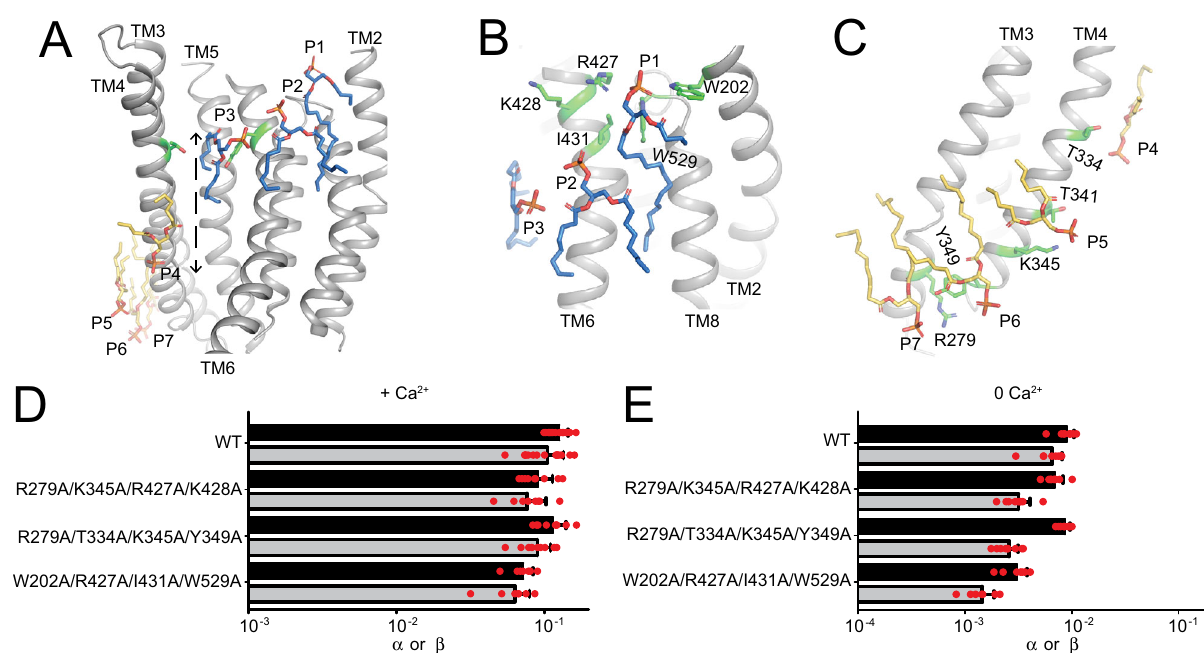
Fig. 2 Coordination of lipids outside the permeation pathway. A View of the seven pathway lipids (in sticks, colored as in Fig. 1H). T325 and Y423 are shown as green sticks. Dashed arrow indicates the distance between the phosphate atoms of the last lipid from the inner (P4) and outer (P3) lea fl ets. B , C Coordination of P1-P2 ( B ) and of P4-P7 ( C ). Side chains are shown in green sticks. D , E forward ( α ) and reverse ( β ) scrambling rate constants for indicated quadruple mutants of residues coordinating lipids outside the pathway (P1-2 and P4-7). Bars are average values for α (black) and β (gray) determined from n = 7 – 16 independent determinations from N = 2 – 8 independent preparations, error bars are S. Dev., and red circles are values from individual repeats. Source data is available in the Source Data fi le.